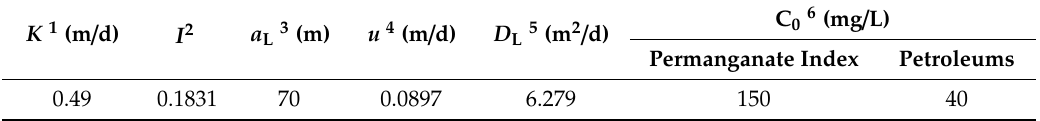
Table 6. Statistical table of calculation parameters.